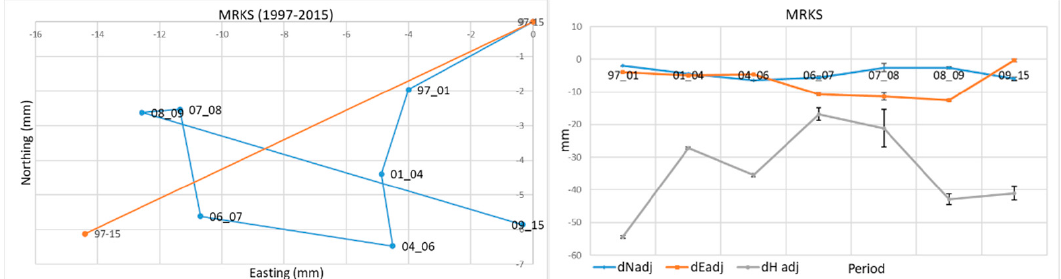
Figure 10. Point BLGS. Larger movements with opposite direction (movement of Zelinska gora). Larger movement values 2008–2009 and 2009–2015. Figure 11. Point MRKS. The continuous direction of movement, average and small movement values. The condition between the movement of Zelinska gora and elevation of the Sljeme mountain (less active part).